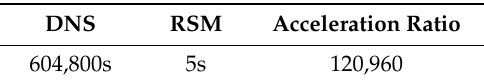
Figure 7. Reynolds shear stress comparison with literature.